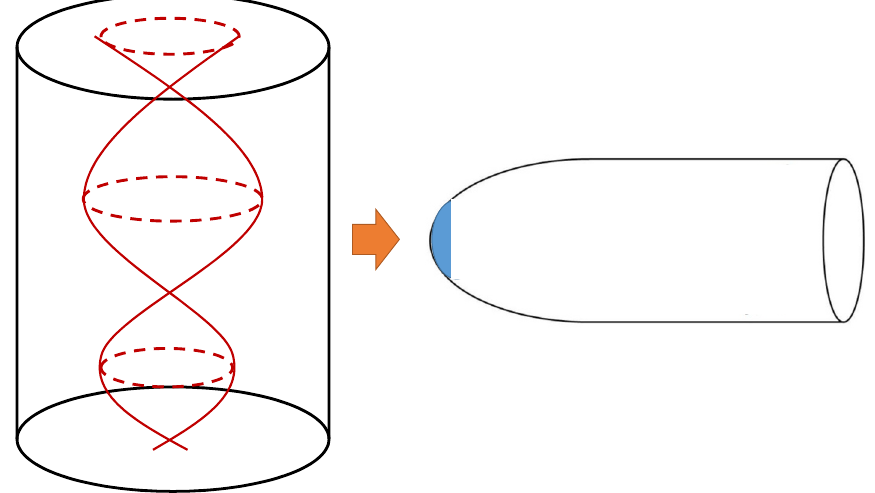
Figure 4 . The pancake solution around the tip of the cigar (on the right) obtained, schematically, by squashing the short string solution in AdS 3 (on the left,